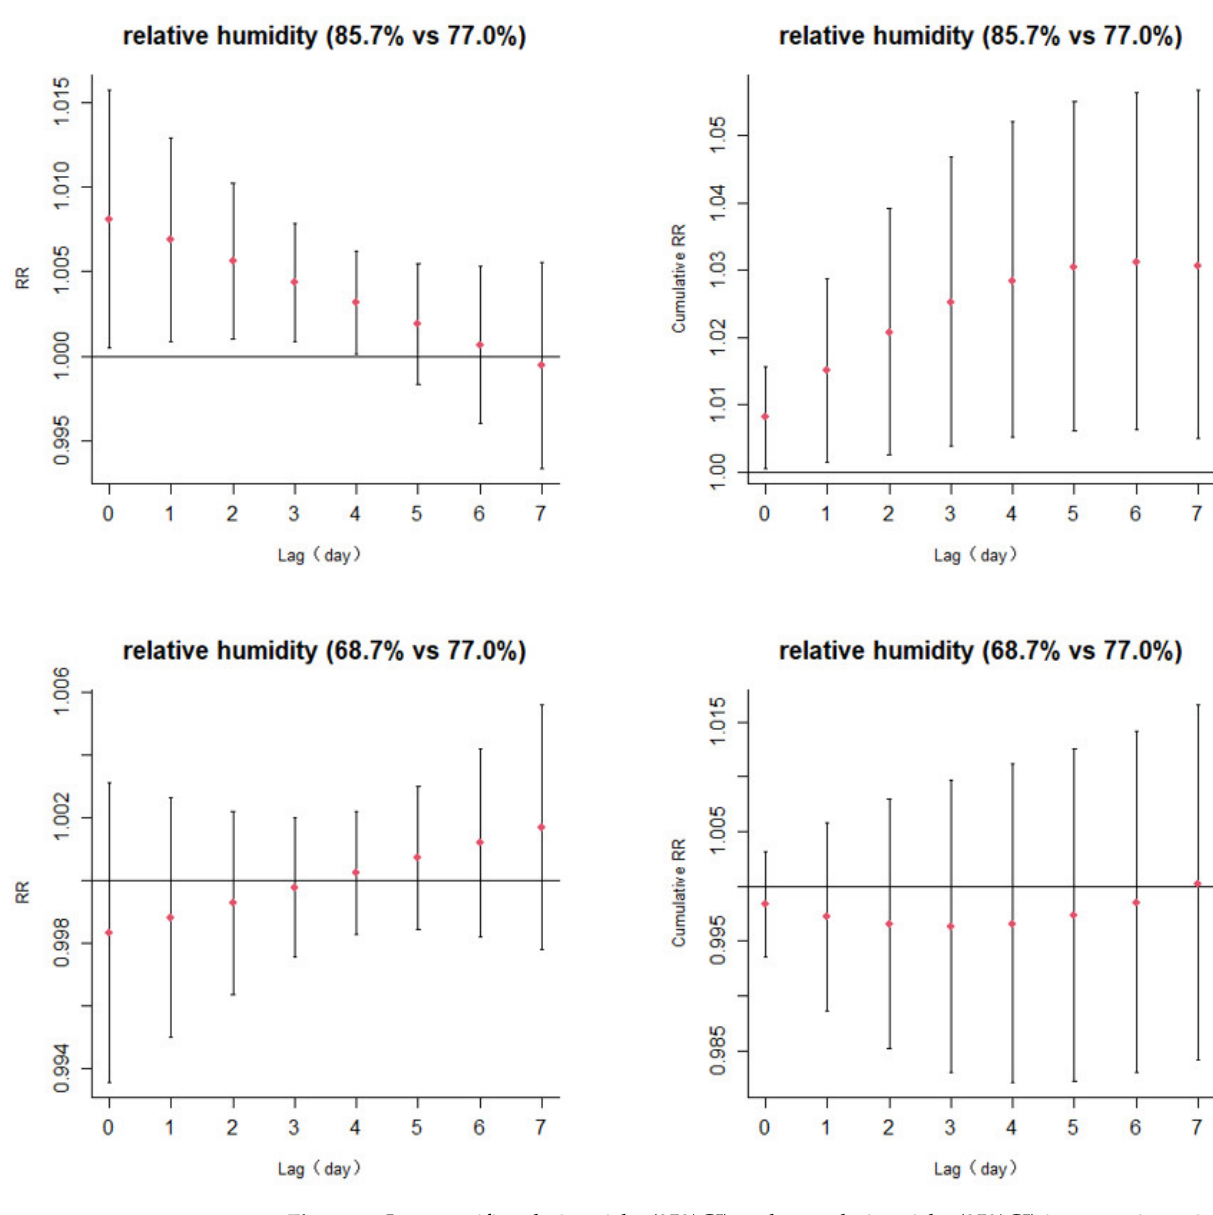
Figure 4. Lag-specific relative risks (95%CI) and cumulative risks (95%CI) in outpatient visits for the herpes zoster with high (75th percentile 85.7%) and low (25th percentile 68.7%) levels of relative humidity in the model.